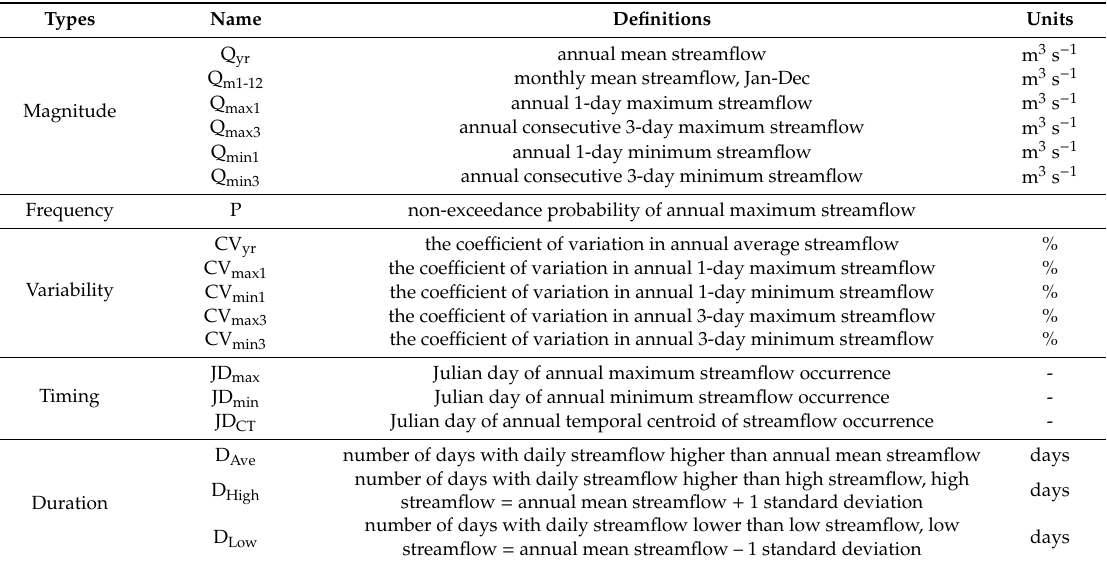
Table 6. Streamflow regime metrics examined for impact